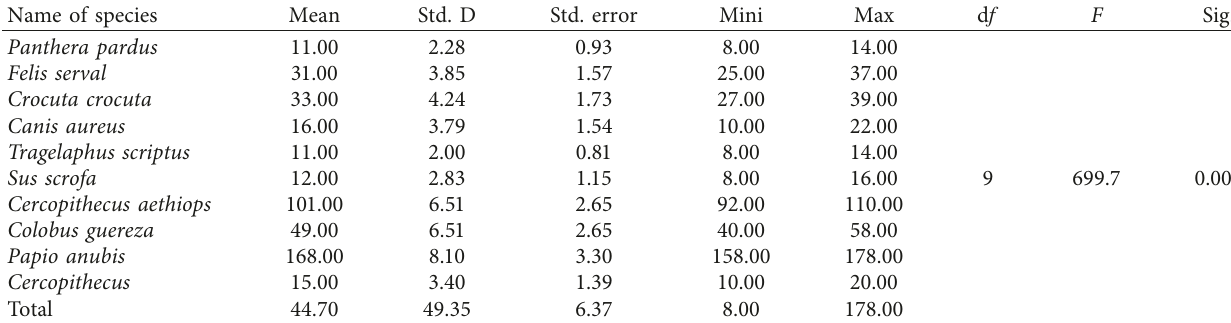
Table 4: Population mean of each species.